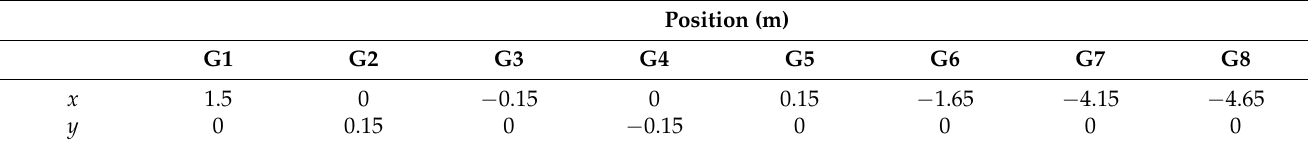
Table 1. Position of the wave gauges.